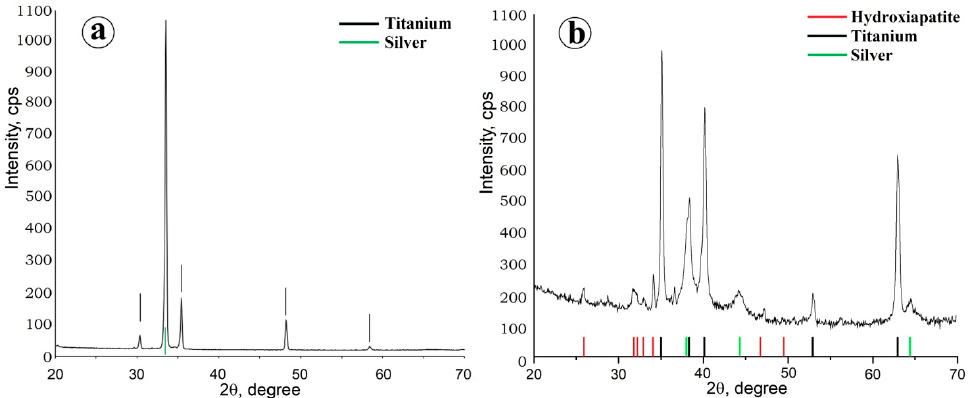
Figure 6. ( a ) SEM image of the chip of the sample with a HAp microparticle array obtained with template electrochemical synthesis; and ( b ) the EDX spectrum recorded at the corresponding points sample with a HAp.